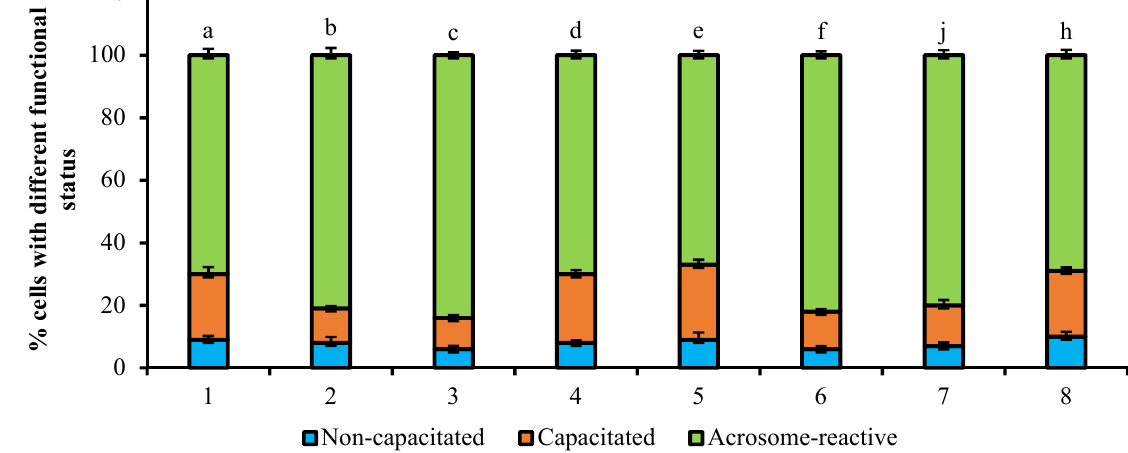
Figure 5. The effect of 10 ng/mL PRL on the time course of acrosome reaction in bovine spermatozoa (total number of counted cells-6400; number of experiments-4). 1—without any reagents (control); 2—with 10 ng/mL PRL; 3—with 10 ng/mL PRL and 10 µ M cytochalasin D; 4—with 10 ng/mL PRL and 10 µ M nocodazole; 5—with 1 mg/mL PRG (control); 6—with mg/mL PRG, 10 ng/mL PRL; 7—with 1 mg/mL PRG, 10 ng/mL PRL and 10 µ M cytochalasin D; 8—with 1 mg/mL PRG, 10 ng/mL PRL and 10 µ M nocodazole. The differences are significant (percent ratio of capacitated and acrosome-reacted